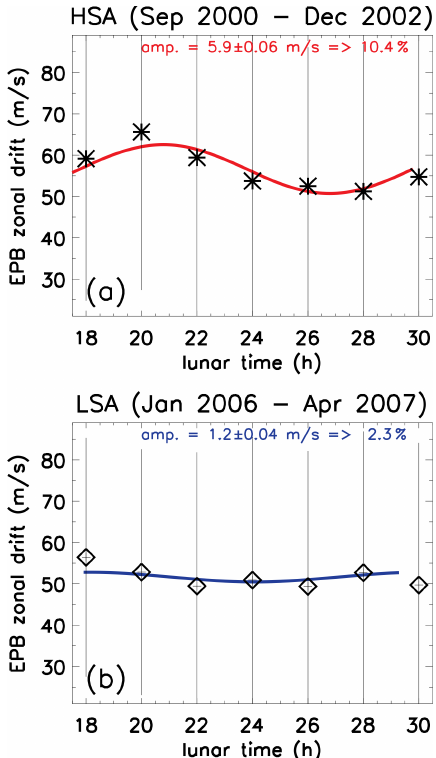
Figure 3. EPB zonal drift (stars) for the HSA (stars in panel a ) and LSA (open diamonds in panel b ) obtained from airglow images and the semidiurnal lunar tide fit (red line in panel a and blue line in panel b ) as a function of lunar time. Error bars represent the stan- dard deviation at each hourly bin. The estimated amplitude and its uncertainty for a 12h oscillation are shown at the top of each